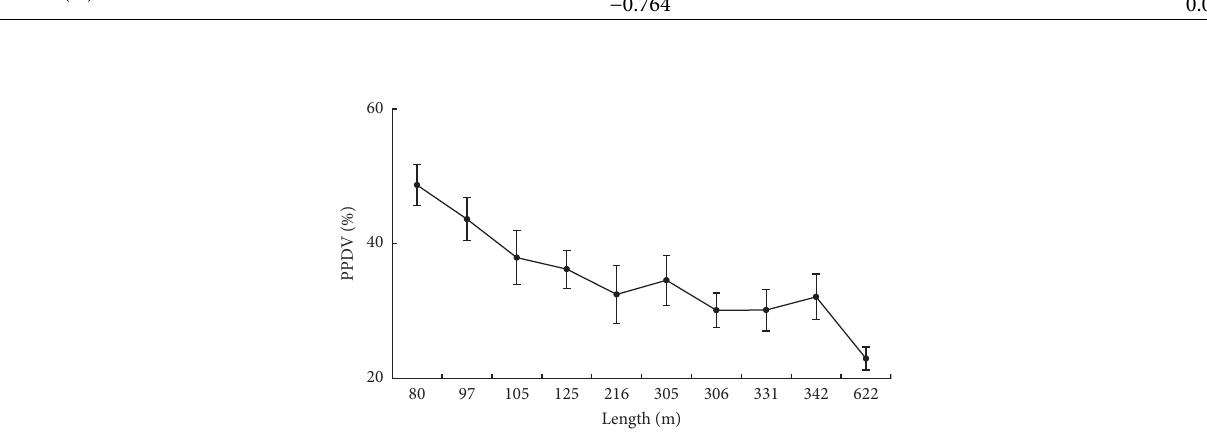
Figure 14: Change analysis of PPDV and different connecting zone